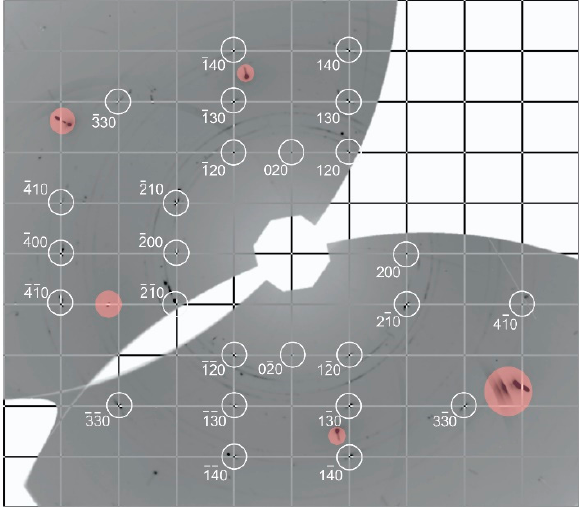
Figure 1. Reconstructed reciprocal lattice planes of orthorhombic Ni 3 C compound with the cementite-type structure. Reflections highlighted by red circles correspond to diamond, diffraction rings correspond to Re, Ni, and LiF.